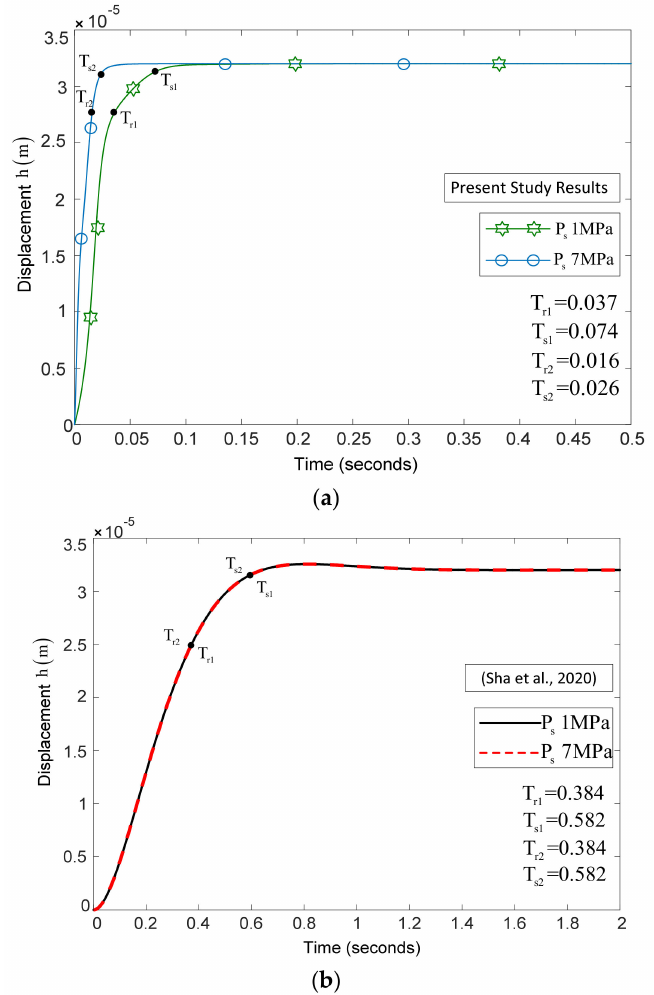
Figure 7. Tracking performance under different supply pressure. ( a ) Present study. ( b ) Literature research work.